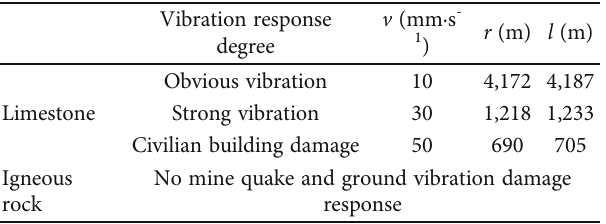
Figure 7: Ground damage boundary type characteristics under di ff erent strata conditions in the stope: (a) Mainly ground movement damage boundary; (b) Movement vibration damage boundary and ground movement damage boundary on the ground. Table 1: Prediction of di ff erent ground vibration damage boundaries during mining in the longwall 16101